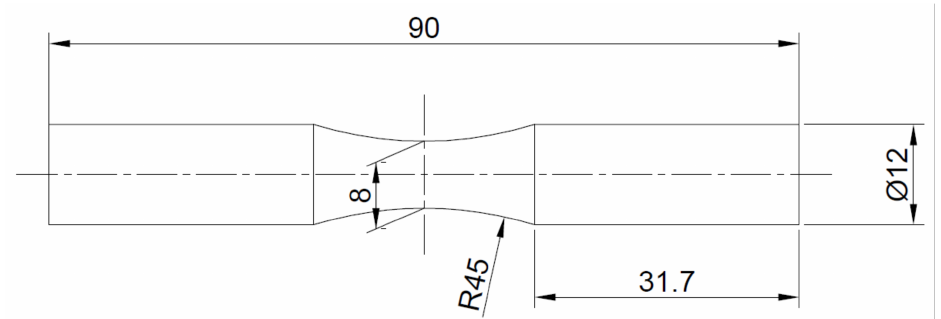
Figure 3. Specimen used in the experiments.